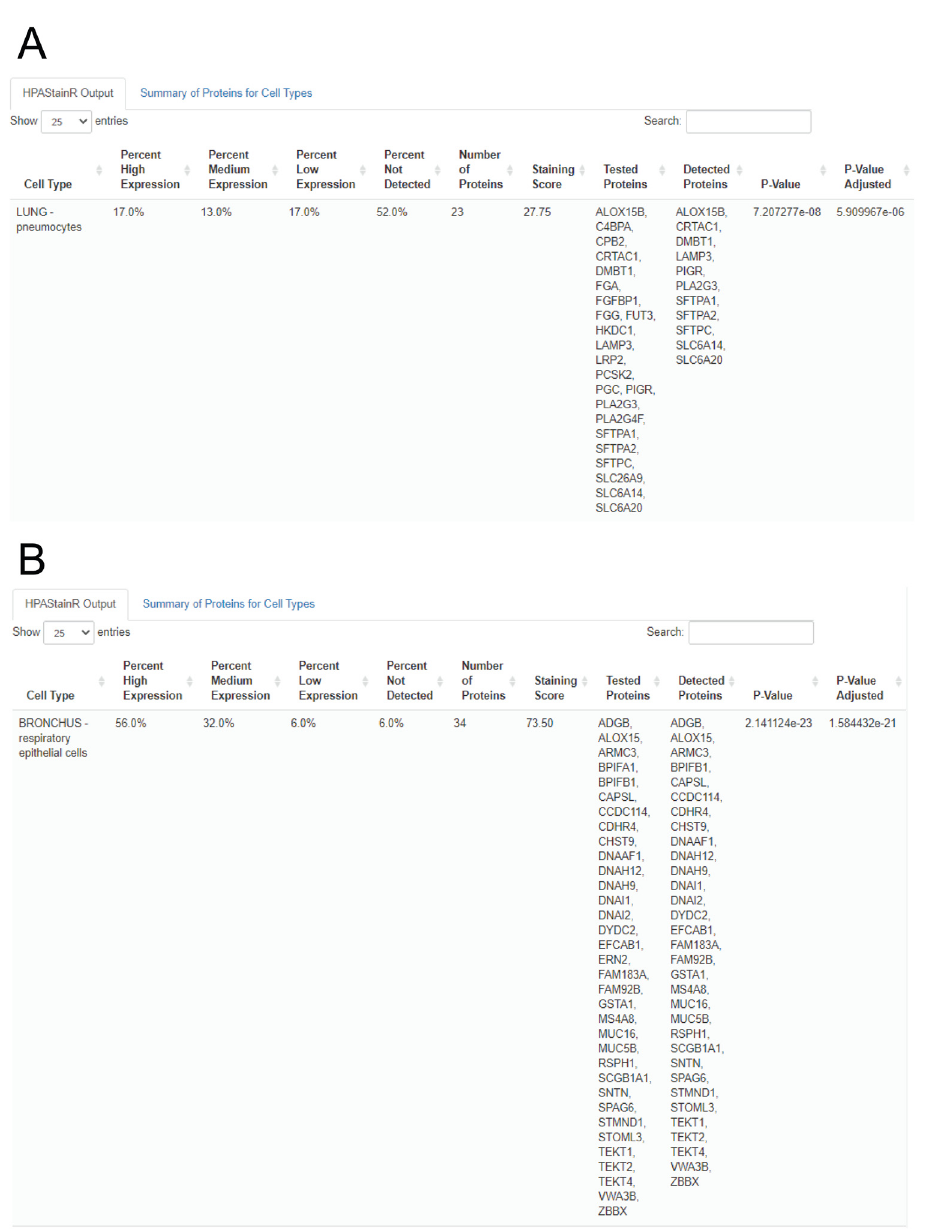
Figure 6. Top HPAStainR results from high variance lung clusters. A . Represents the output when a list of genes associated with pneumocytes are used as input. B . Represents the output when a list of genes associated with the bronchial epithelium are used as